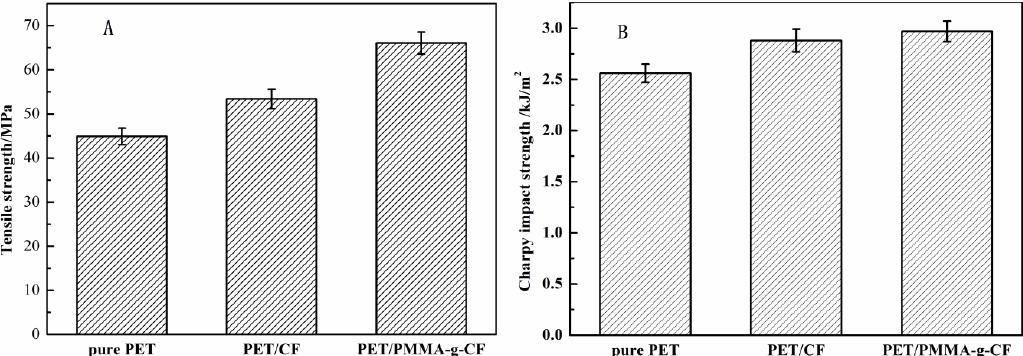
Figure 14. ( A ) Tensile strength and ( B ) Charpy impact strength of pure PET, PET/CF, and Figure 14. ( A) Tensile strength and ( B ) Charpy impact strength of pure PET, PET/CF, and PET/PMMA-g-CF PET/PMMA-g-CF composites.